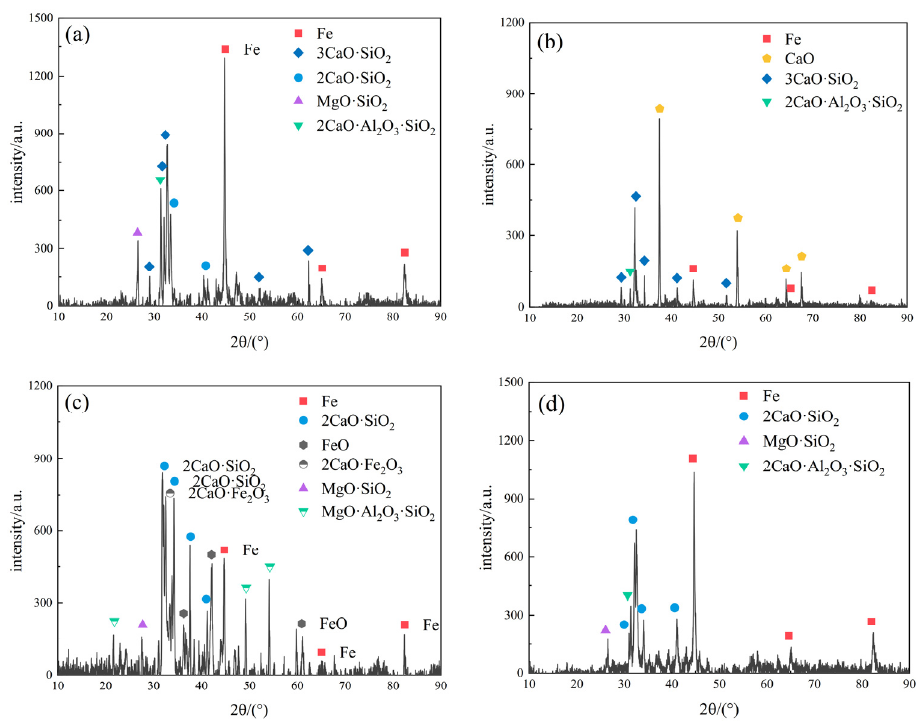
Figure 14. XRD characterization of the coupled system under different thermodynamic conditions: ( a ) the coexistence of iron and cementitious materials; ( b ) excessive CaO; ( c ) an incomplete reduction of iron; ( d ) the incomplete formation of cementitious material.